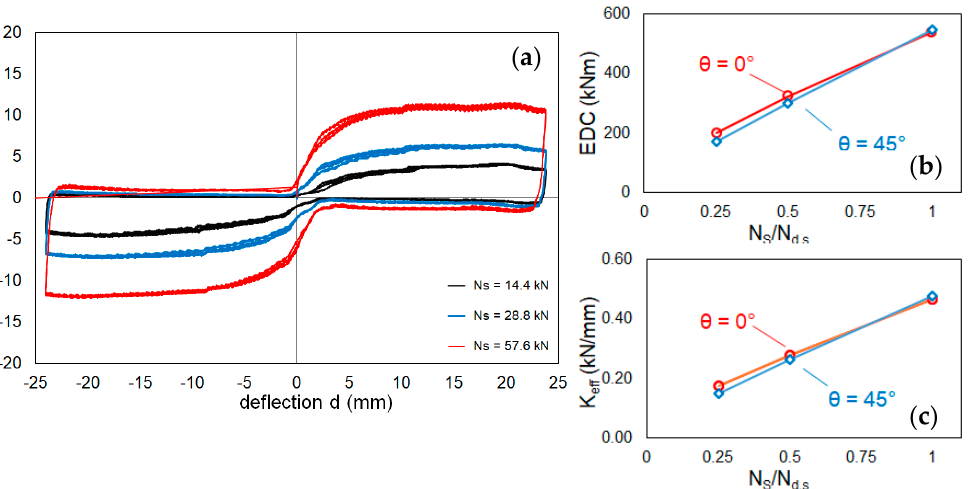
Figure 13. Static Test with Rotation (R): ( a ) horizontal force—deflection diagrams at different levels of vertical load; ( b ) energy dissipated per cycle edc and ( c ) effective stiffness K eff along the rotated trajectory ( θ = 45°) vs. on-axis trajectory ( θ = 0°).